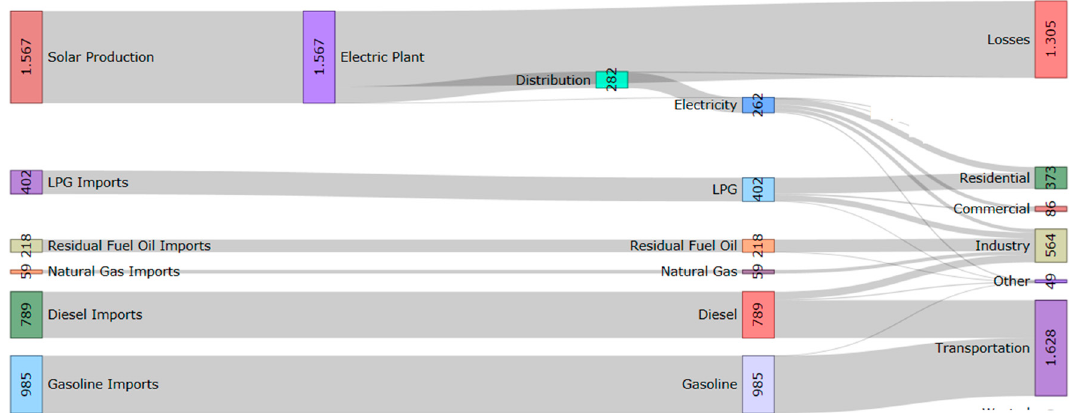
Figure 8. The Sankey diagram of the energy situation of Cuenca after taking advantage of photovoltaic solar energy.